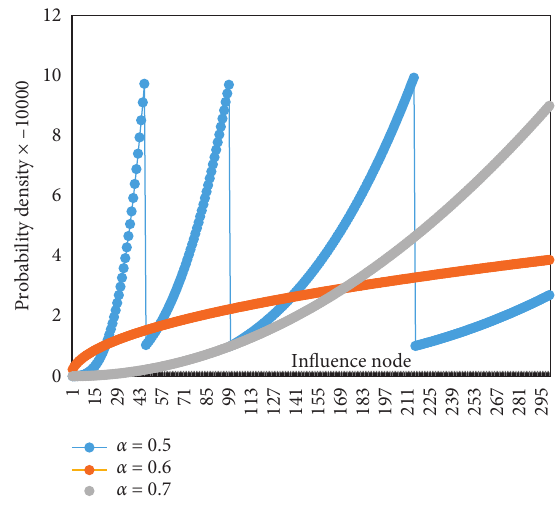
Figure 5: The probability threshold of α .